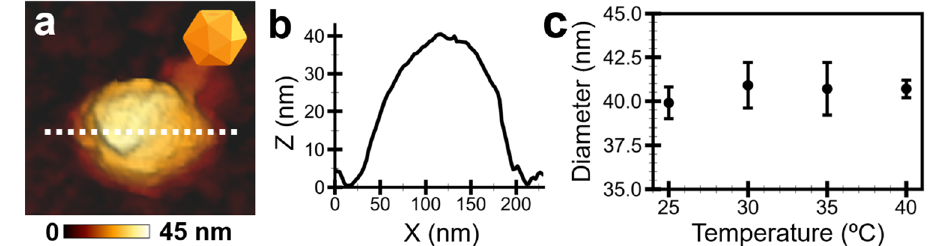
Figure 2. The size of a C22 phage particle examined by AFM. ( a ) AFM image of a C22 phage particle in the MES buffer at 25 °C. The color gradient scale bar indicated the height (Z-direction). The orange inset demonstrated an icosahedral shape. ( b ) The particle diameter was extracted from the particle’s cross-section (white dashed line). ( c ) The average diameter of the C22 phage particles at 25, 30, 35, and 40 °C was about 40 nm. The error bars represented standard deviations (s.d.) of 50